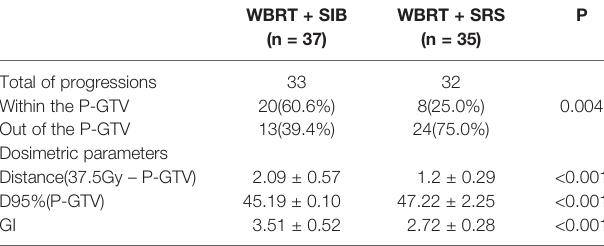
TABLE 3 | Pattern of intracranial progression and dosimetric